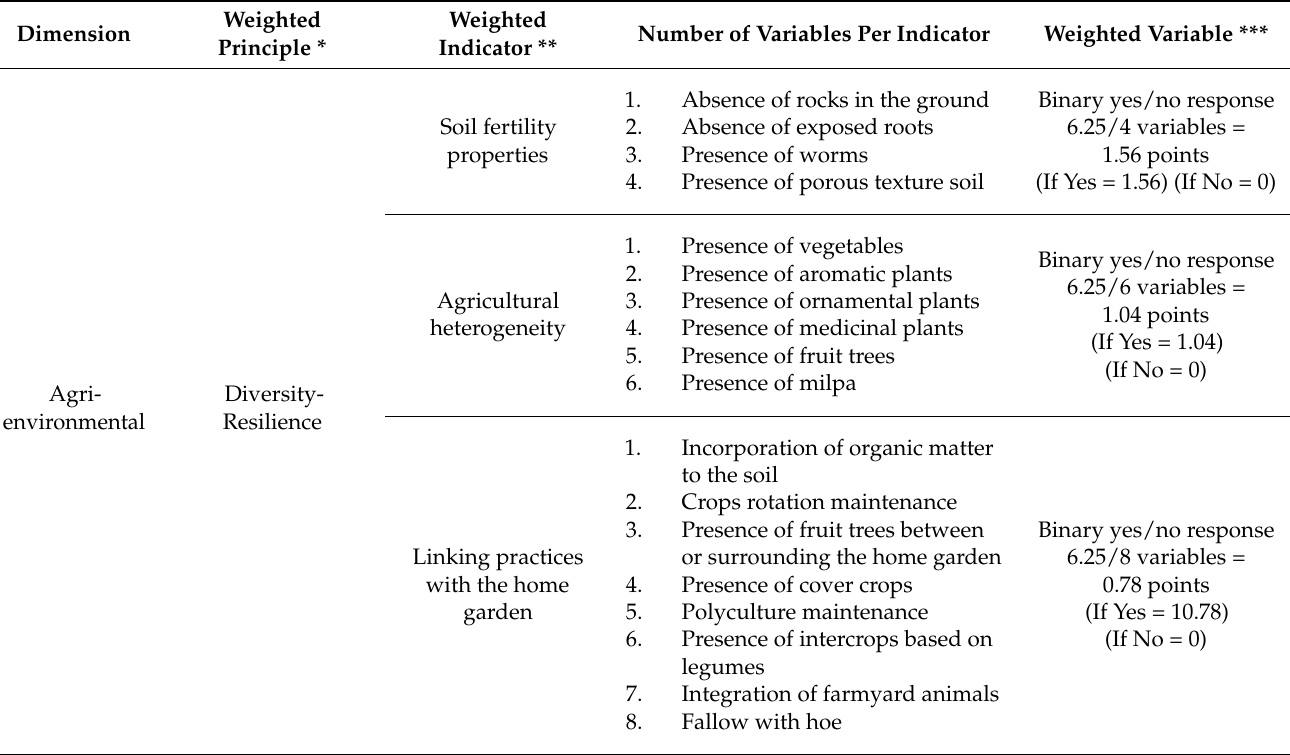
Table 2. Principles, indicators, and variables of